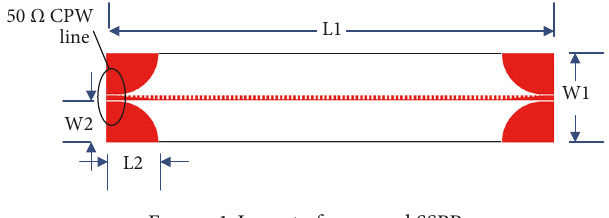
Figure 1: Layout of proposed SSPP.